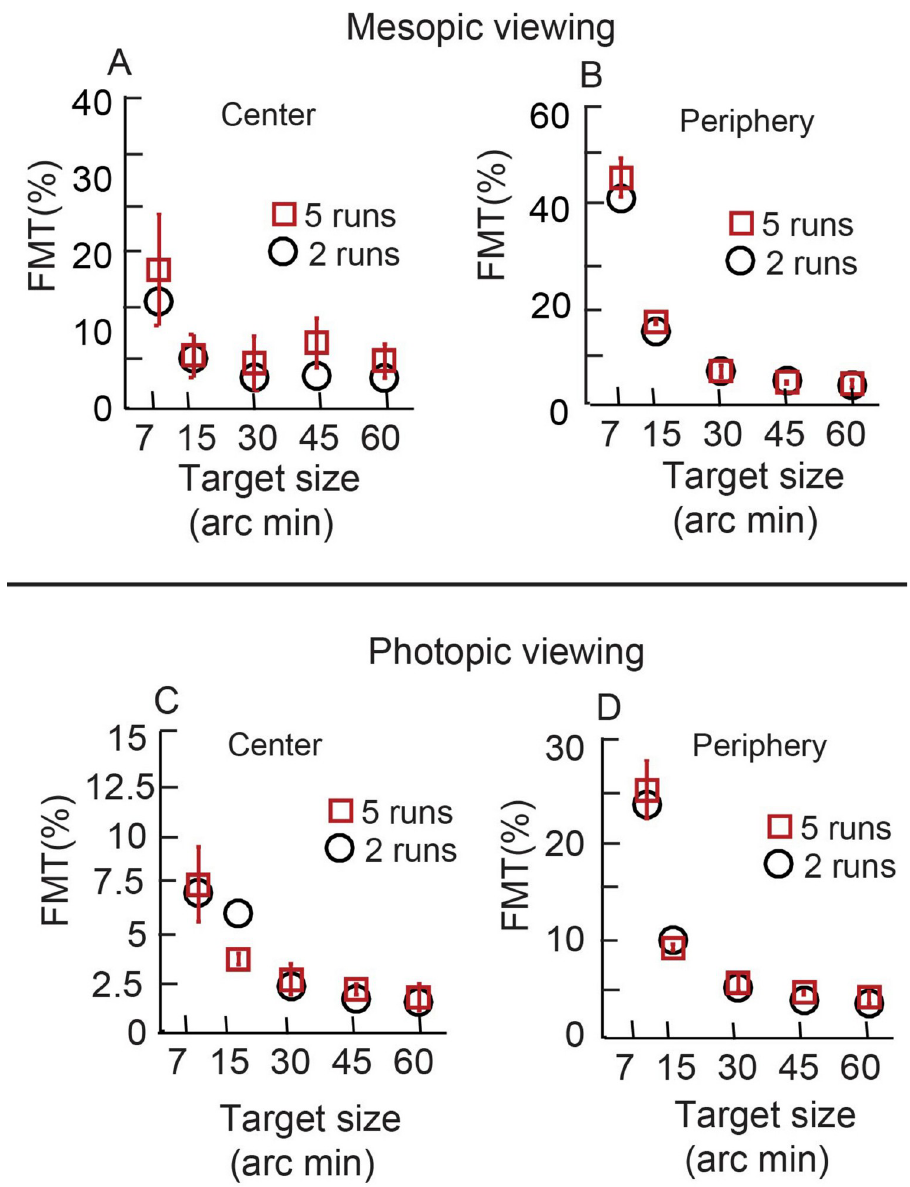
Fig 8. Representation of better of the two eyes’ monocular FMTs and binocular FMTs. Mean ( ± 1SD) binocular FMTs obtained under mesopic (left panels; n = 1) and photopic (right panels; n = 3) viewing conditions for different stimulus sizes at the point of regard (panels A and B) and the four parafoveal locations (panels c and d) for 2 runs and 5 runs of the same experiment. Data from all four parafoveal locations are averaged in this figure.